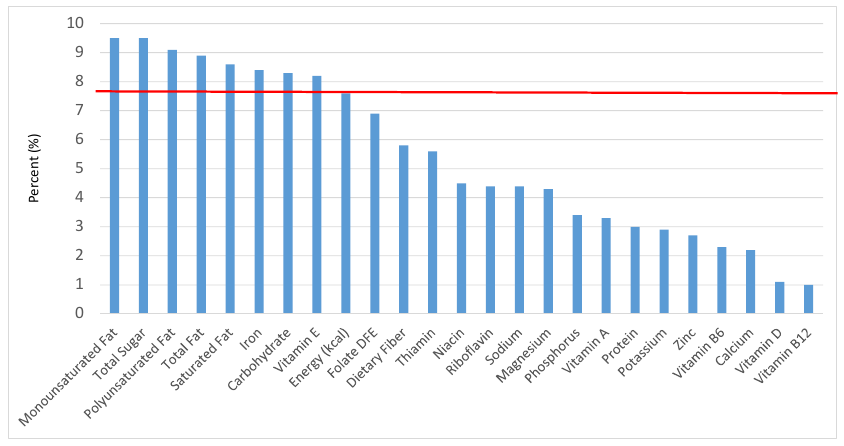
Figure 29. Sweet bakery products as sources of energy and nutrients for children and adolescents 9–13 years old ( N = 1730, daily intake data): DFE = Dietary Folate Equivalents; solid red line represents percentage of energy (kcal) provided in the diet relative to nutrients—nutrients above the red line show the grain food’s contribution to nutrient density.